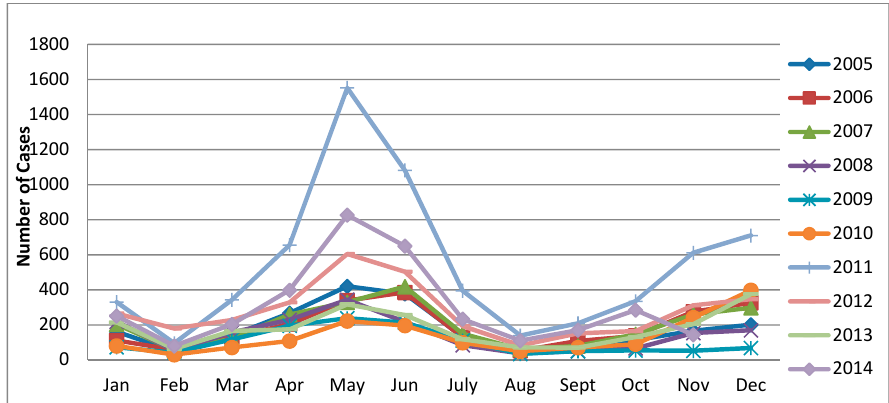
Figure 2. Monthly incidence of scarlet fever in Beijing, China, 2005–2014.